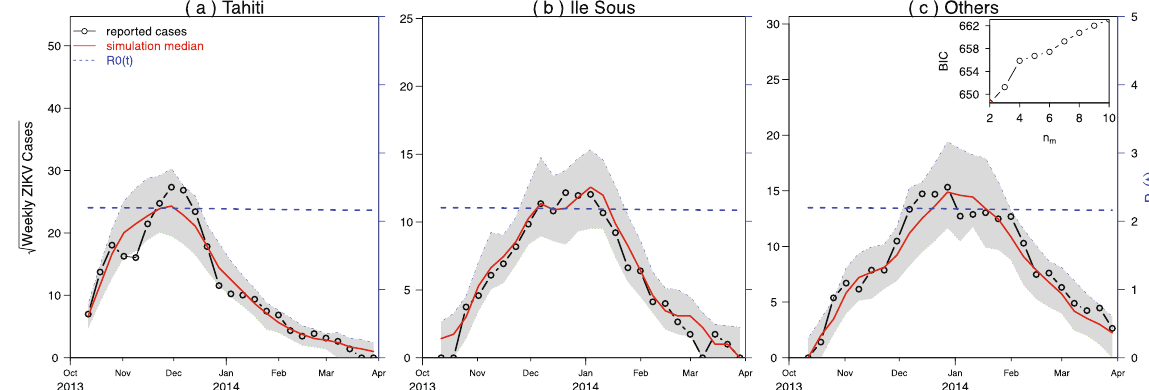
Figure 5. Fitting model to French Polynesia regional level ZIKV cases with the weekly proportion of stations reporting. In each region, the reporting ratio of symptomatic cases is the baseline reporting ratio ( ρ ) multiplied by the proportion of stations reporting in each week. We used loess to convert the weekly proportion of stations data into daily data.